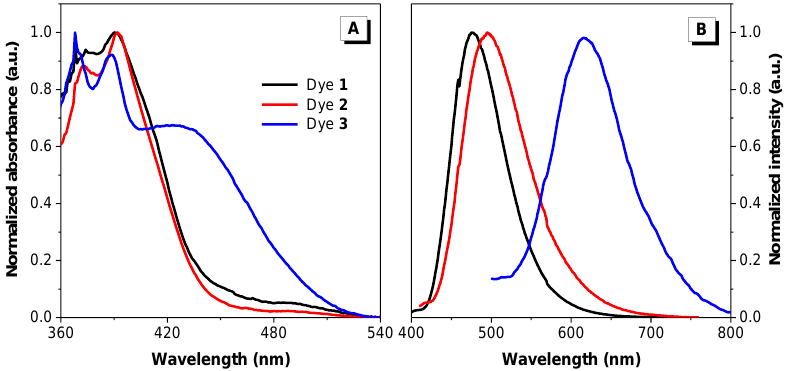
Figure 3. ( A ) Normalized absorption and ( B ) emission spectra in DMSO. Concentration = 10 µM. Excitation wavelength: 390 (1), 392 (2) and 420 nm (3).